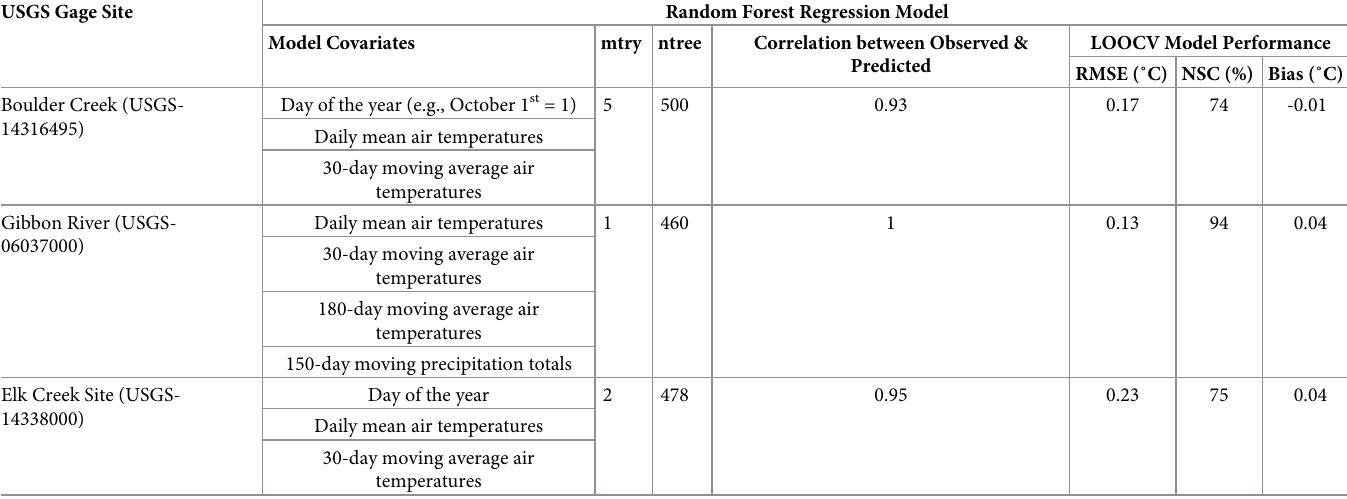
Table 8. Fitness, structure, and performance of best fit random forest regression models for the winter mean water temperatures and accumulated degree-days of studied stream sites.